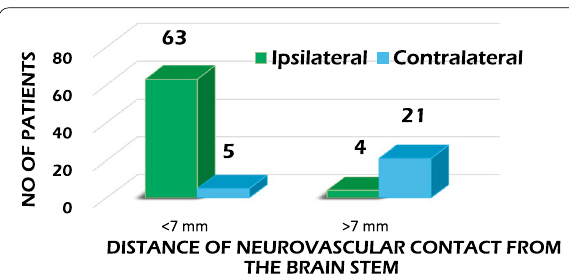
Fig. 3 Bar graph showing the distance of NVC of trigeminal nerve from brainstem ipsilateral (symptomatic) and contralateral (asymptomatic)